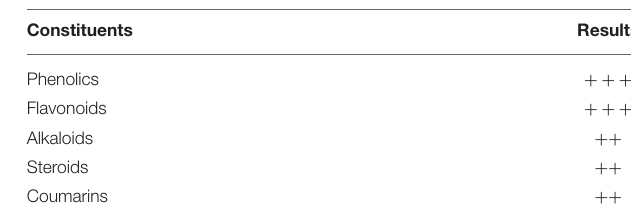
TABLE 1 | Phytochemical constituents present in ethyl acetate leaf extracts of D. pinnata